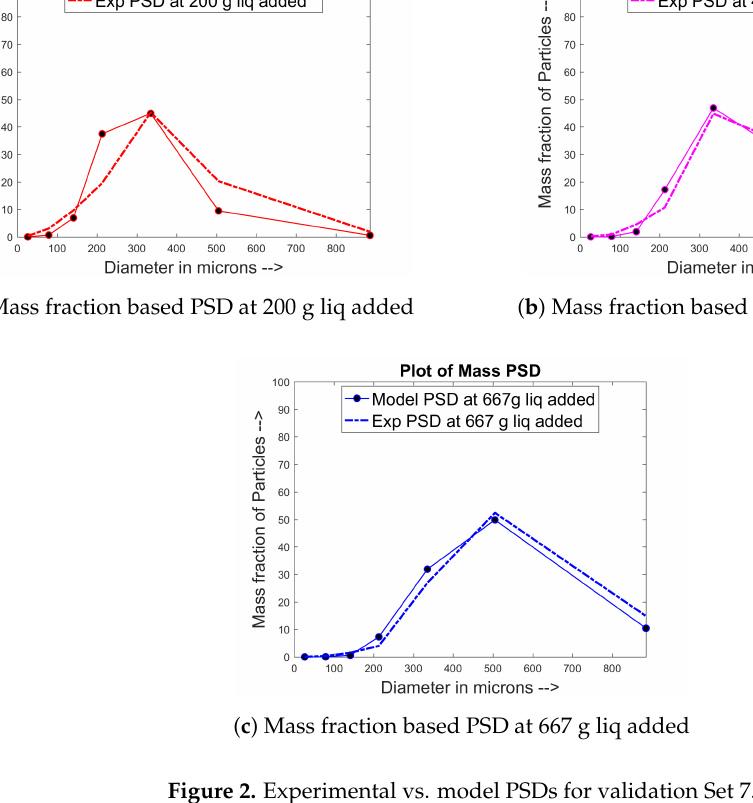
Figure 2. Experimental vs. model PSDs for validation Set